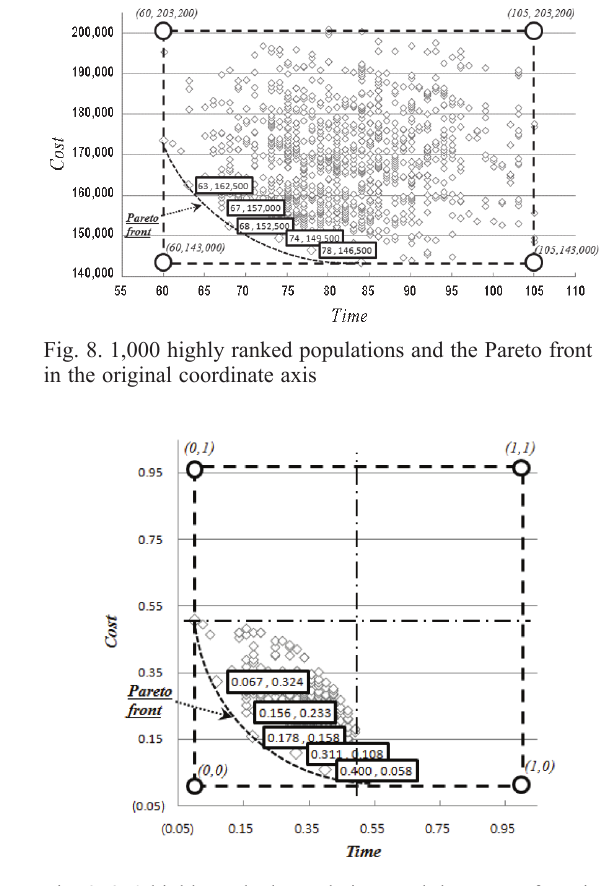
Fig. 9. 250 highly ranked populations and the Pareto front in the standardized coordinate